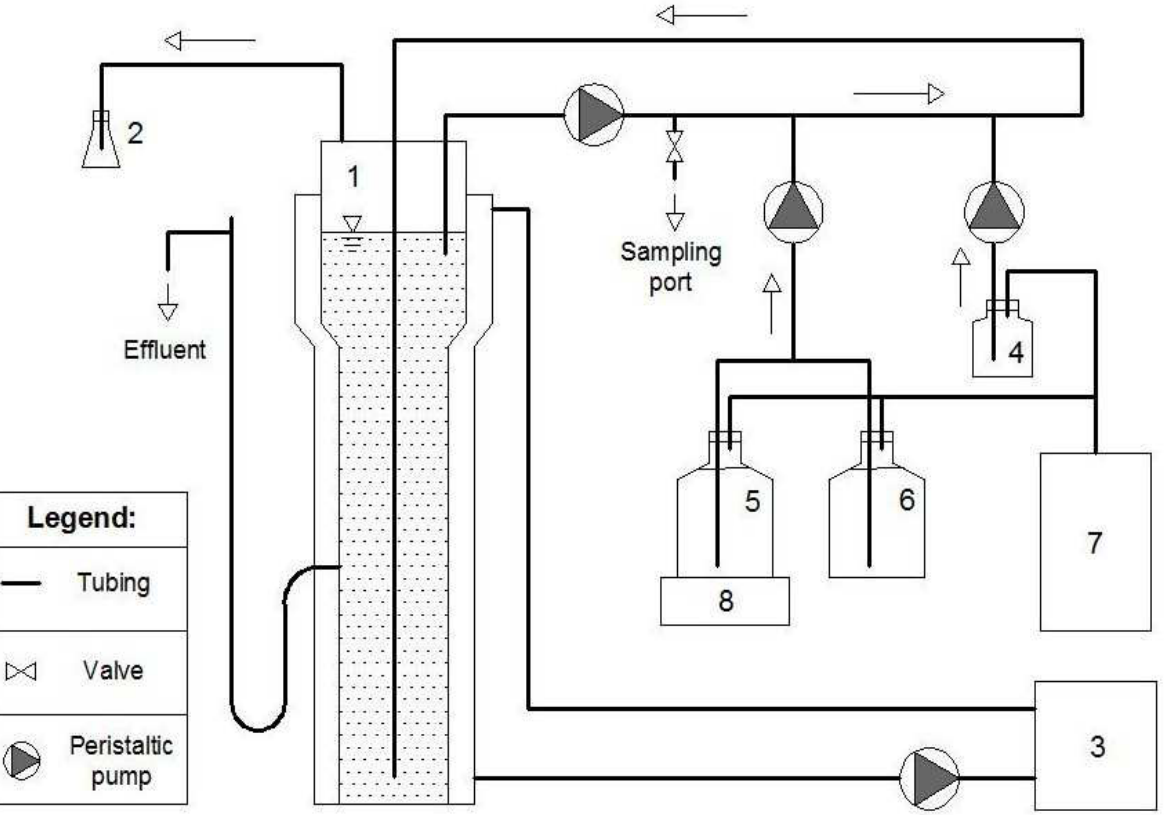
Figure 1. Schematic diagram of the lab-scale setup of